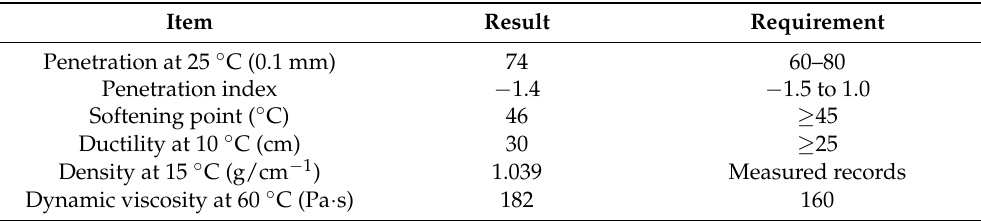
Table 1. Main indexes of